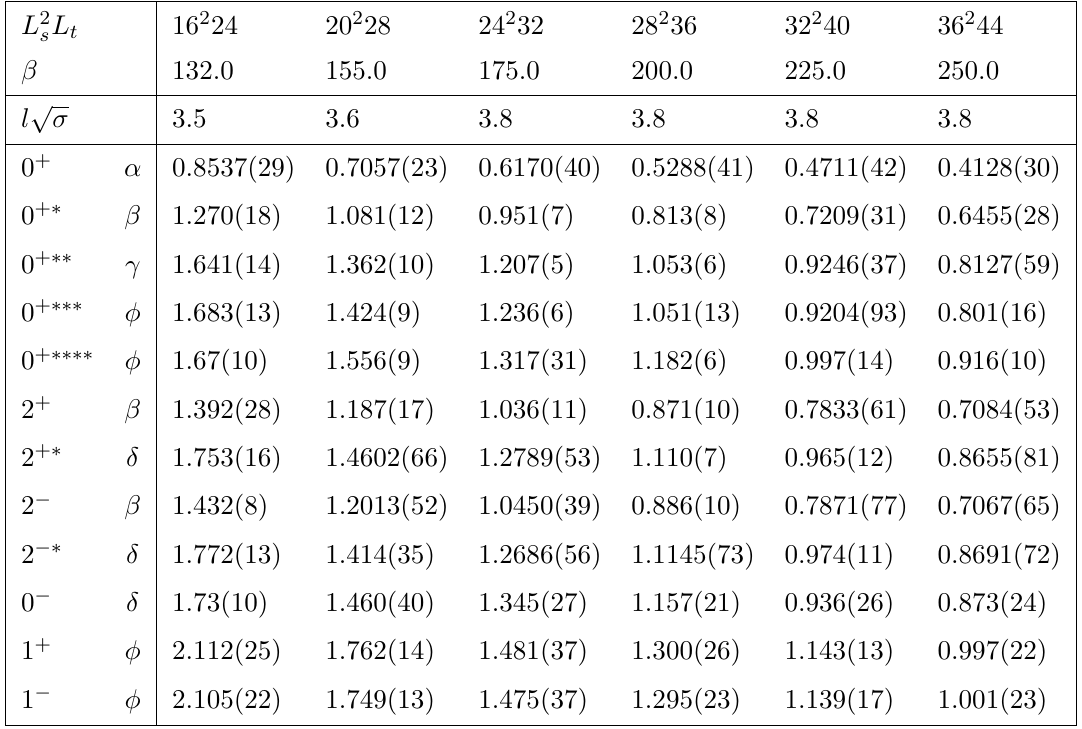
Table 26 . SO(12) glueball masses am G . Grades, e.g. (cid:11) , explained in section 3.6.6. L 2 L t s